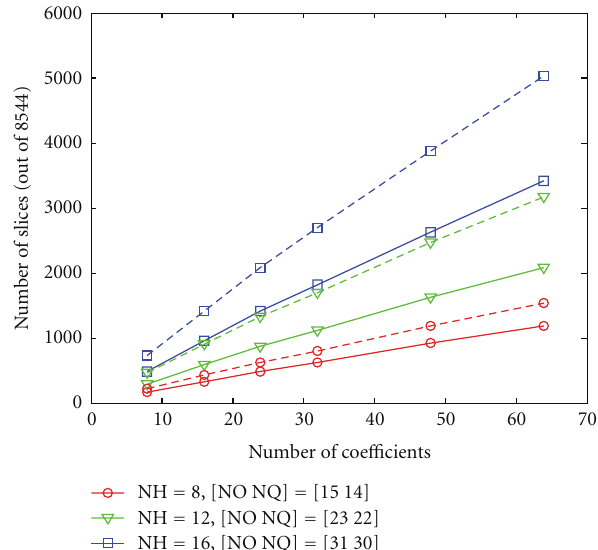
Figure 11: Resources versus number of coe ffi cients and input bit- width. Solid lines represent the symmetric case. Dotted lines repre- sent the nonsymmetric case.